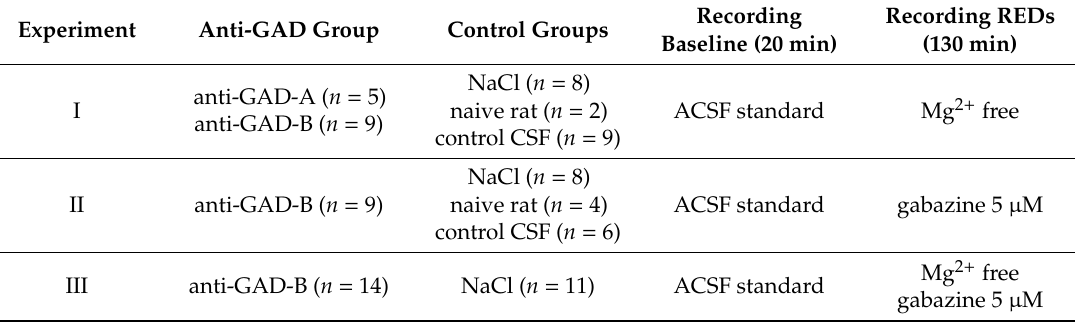
Table 1. Experimental groups. Number of slices is given in parentheses.